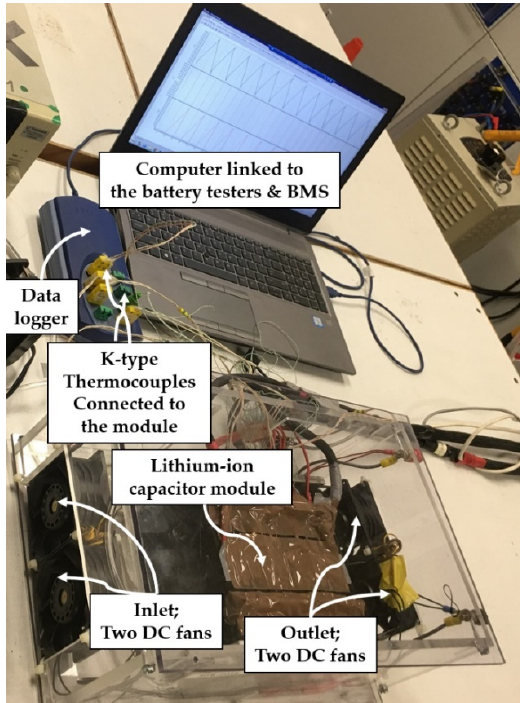
Figure 3. The forced ACTMS experimental test bench for the LiC module.